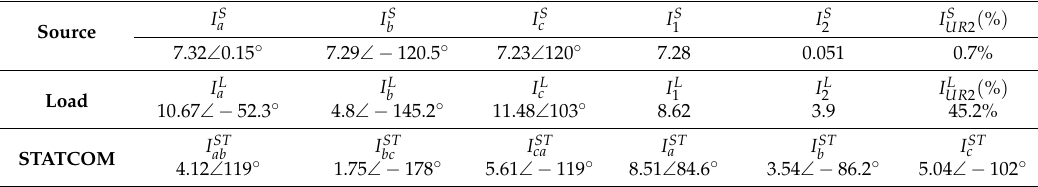
Table 1. Three-phase source, load and STATCOM currents after compensation.